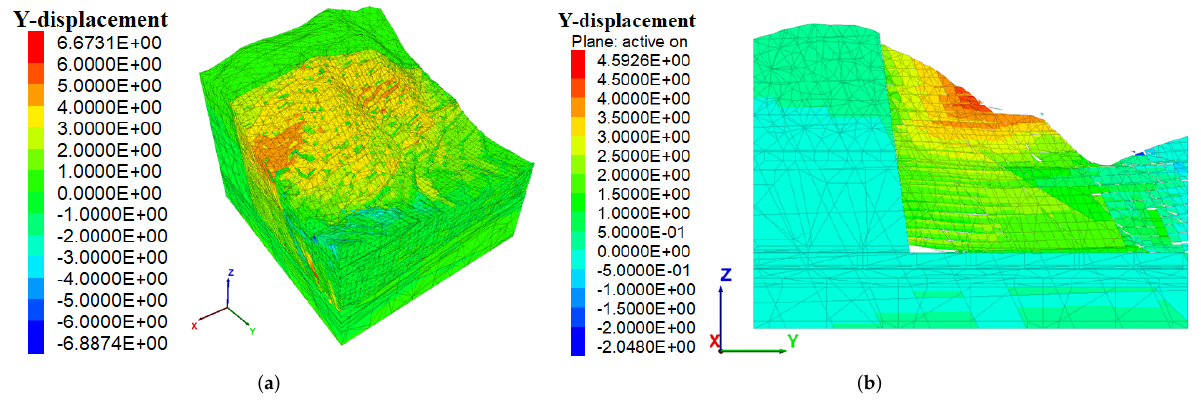
Figure 12. The Y-direction displacement after excavating 9# and 10# coal seams. ( a ) Overview,